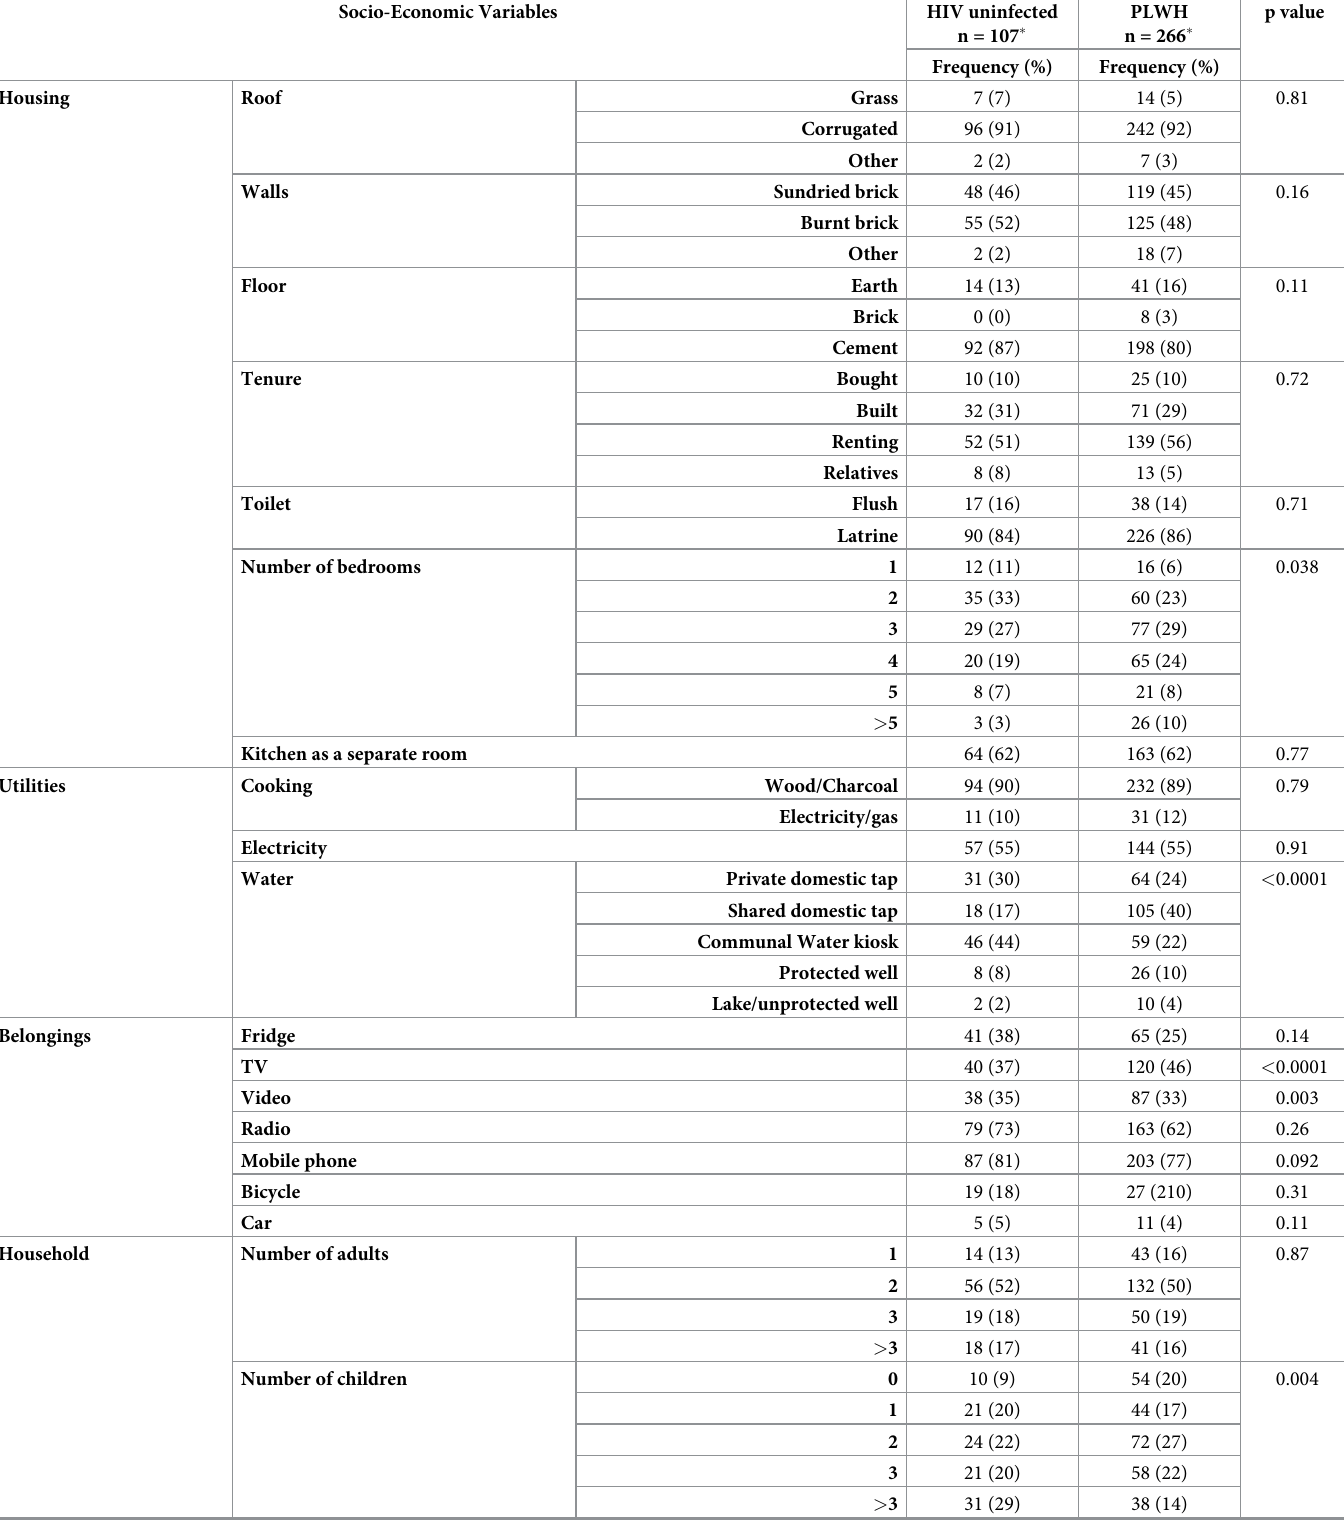
Table 1. Socio-economic variables for 367 Malawian adults according to HIV